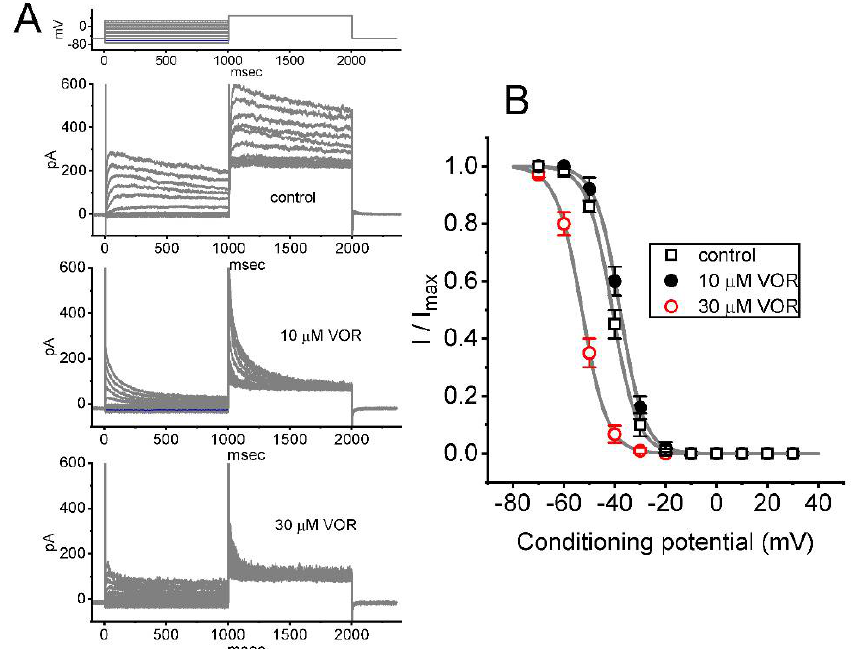
Figure 4. The steady-state inactivation curve of I K(DR) in the control period (i.e., VOR was not present) and during cell exposure to 10 or 30 µ M VOR. The experiments were conducted with a two-step voltage protocol (indicated in the uppermost part of (A)). ( A ) Representative current traces obtained in the absence (upper) and presence of 10 µ M VOR (middle) or 30 µ M VOR (lower). ( B ) The relationships of the conditioning potential versus the normalized amplitude of I K(DR) in the control period (open black squares) and during cell exposure to 10 µ M VOR (filled black circles) or 30 µ M VOR (open red circles). The data represents the mean ± SEM (n = 8 for each point). The continuous curves were obtained with the goodness-of-fit test by a Boltzmann function, as described in Materials and Methods.